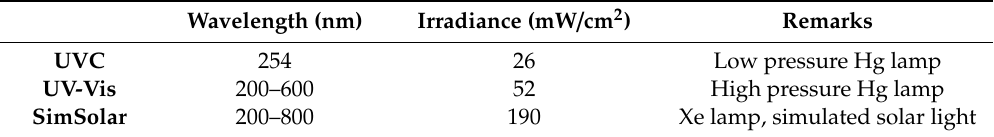
Table 2. Main characteristics of the light sources used in the photodegradation